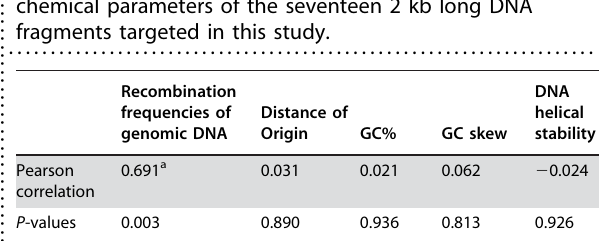
Table 2. Correlation coefficients of plasmid DNA recombination frequencies with the genomic DNA recombination frequencies and with the main physico- chemical parameters of the seventeen 2 kb long DNA